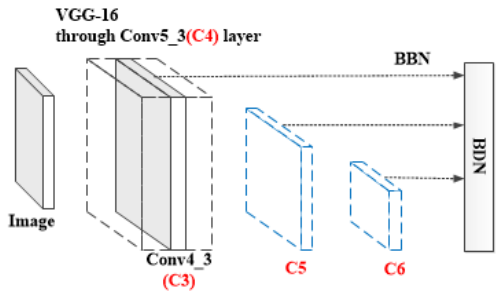
Figure 6. The kilometer post detection model based on an improved SSD algorithm.